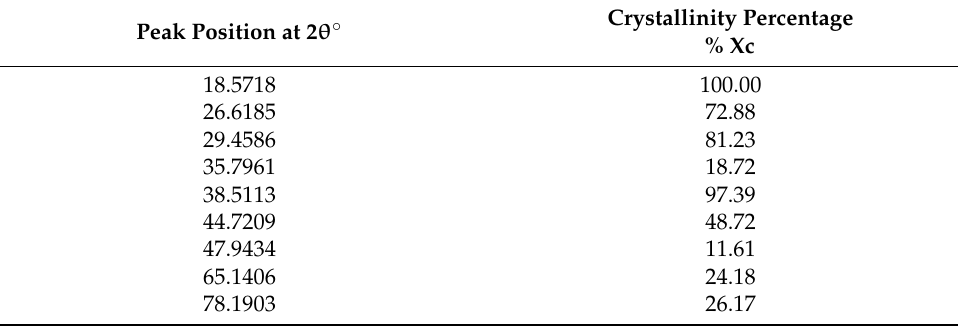
Table 4. XRD intensity scan data of recovered rubber.